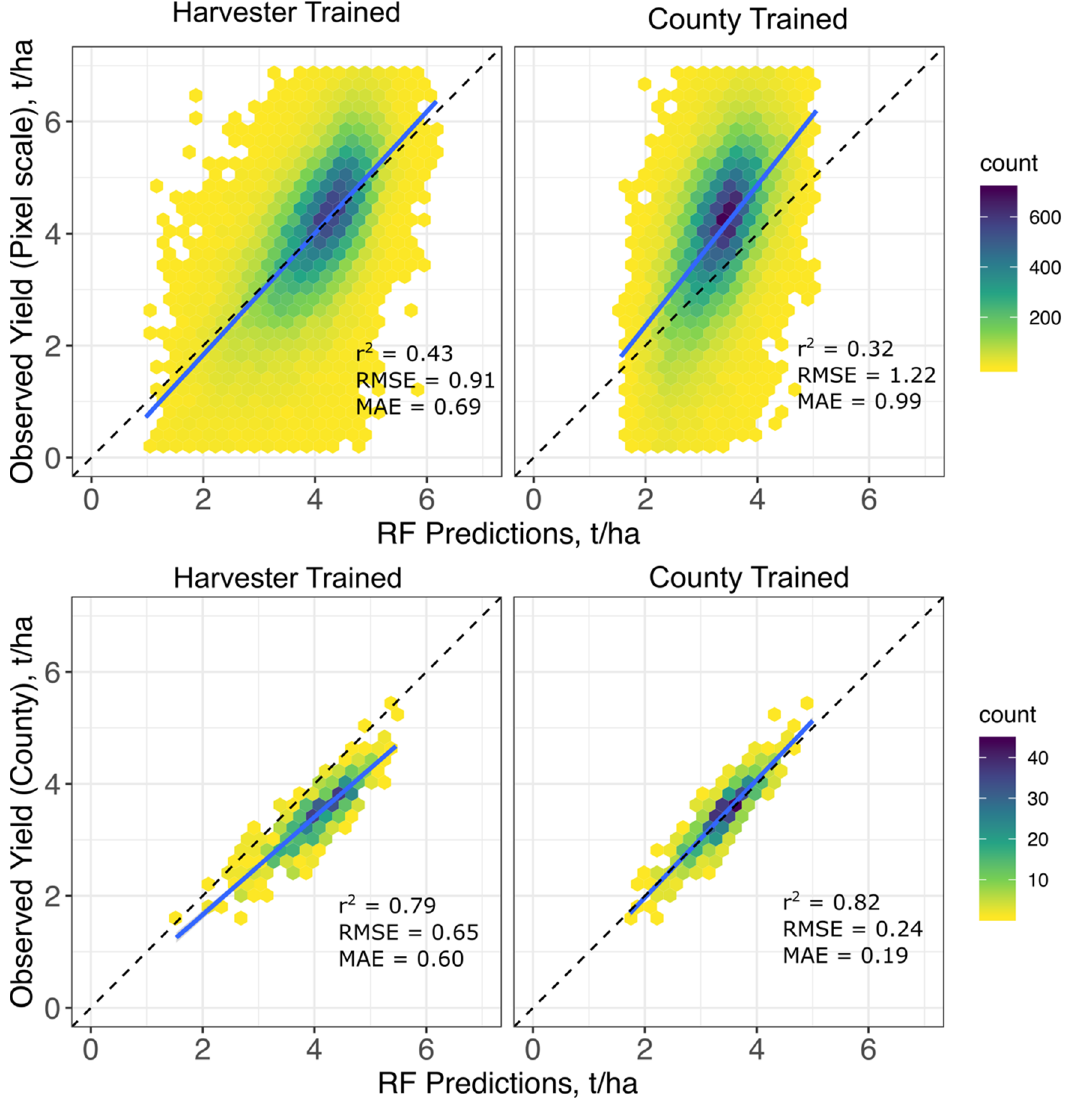
Figure 5. County- and Pixel-Scale Random Forest Validation. The figure shows validation statistics on held-out data for random forests trained at the pixel-scale (Harvester Trained) and county-scale (County Trained). Both models employ a monthly time series of Landsat and weather data. RMSE and MAE are reported in t/ha.